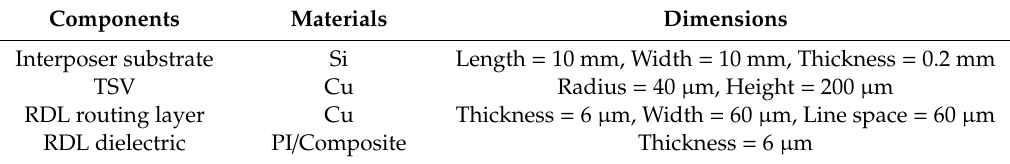
Table 2. Specifications for all components of the interposer test